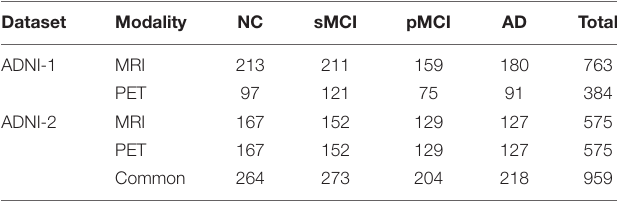
TABLE 1 | Number of subjects utilized in our work.